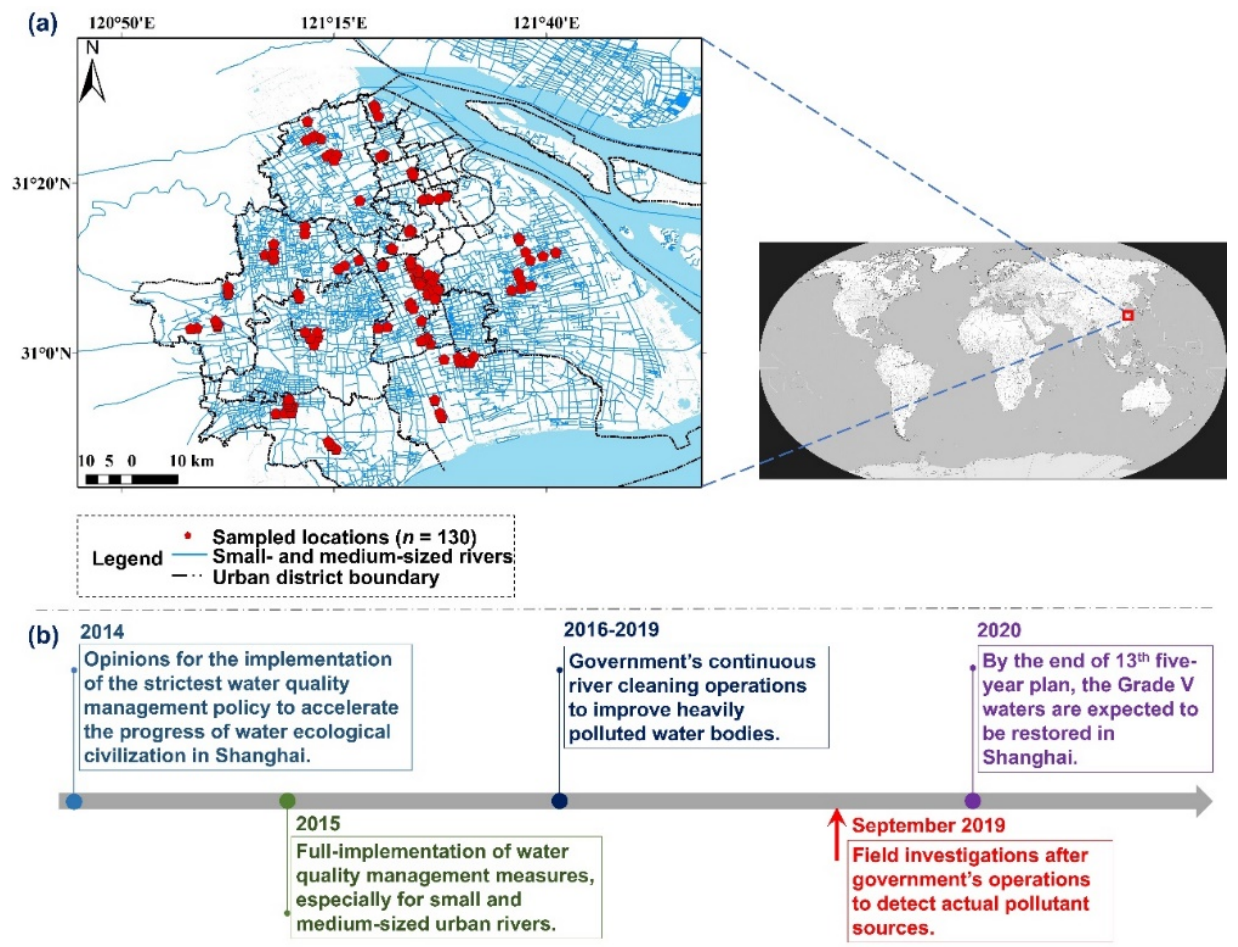
Figure 1. ( a ): Locations of 130 sampled sections in Shanghai’s small- and medium-sized rives. ( b ): Timeline for Shanghai’s river water quality managing operations in the years 2014–2020.